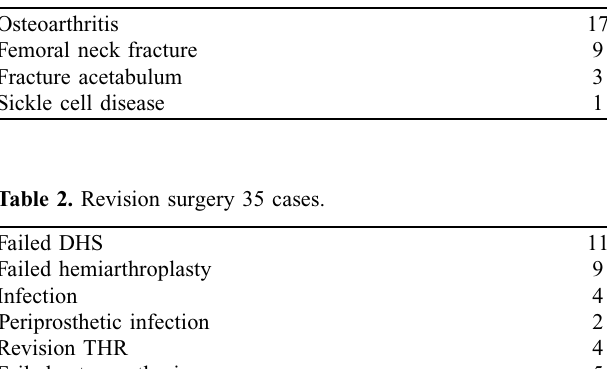
Table 1. Primary THR 30